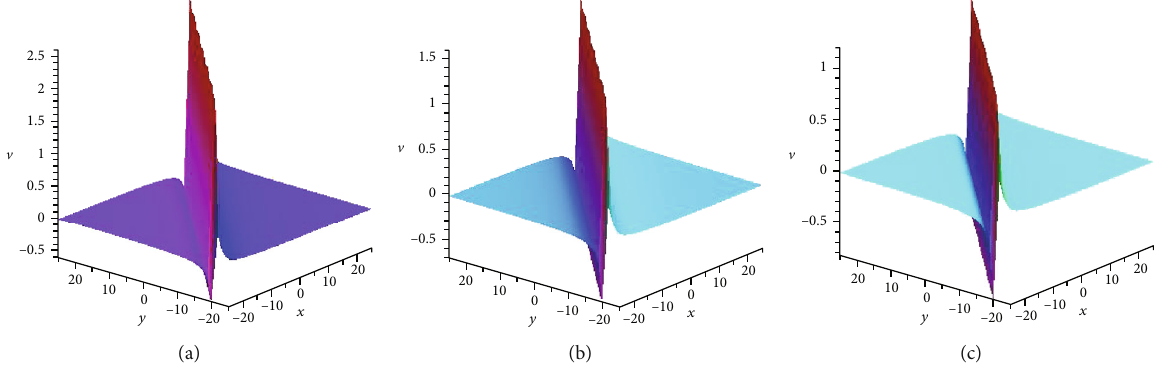
Figure 6: Evolution of Equation (66) at (a) t = 16 , (b) t = 18 , and (c) t = 20